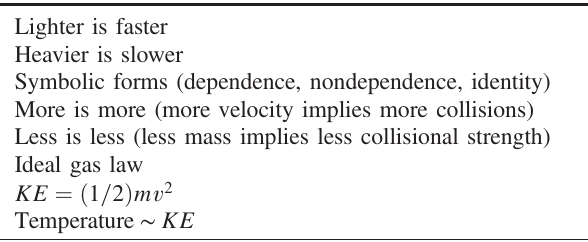
TABLE IV. Resources used in the changing gas